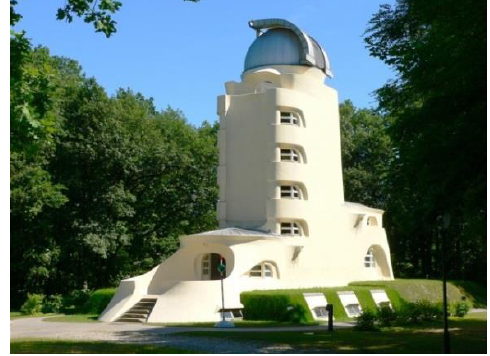
Fig. 27 Einstein astronomic observatory, Potsdam